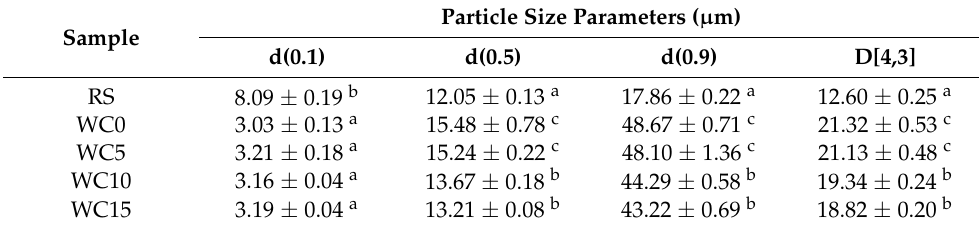
presented in Table 3. Table 3. Particle size parameters of RS and enriched chocolate. Table 3. Particle size parameters of RS and enriched chocolate.